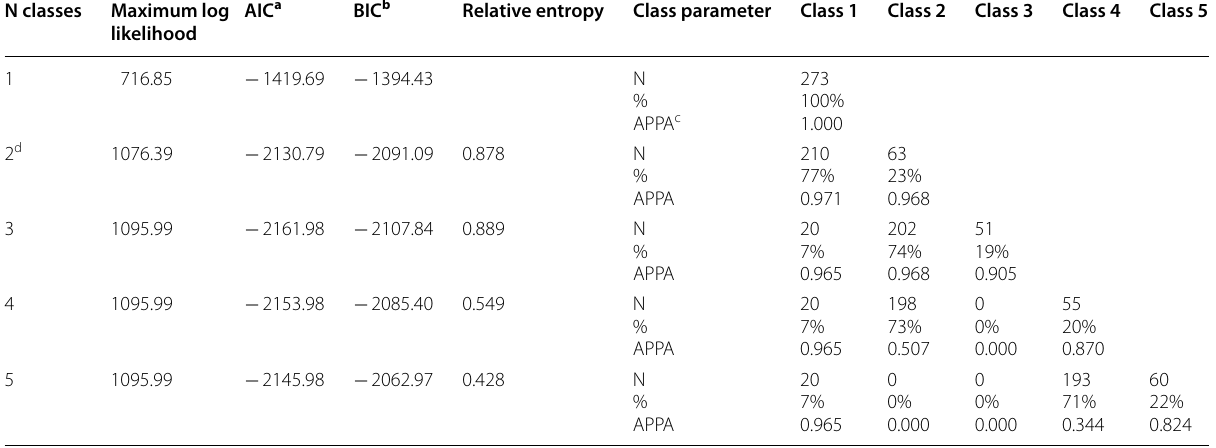
273) using a Quadratic Trajectory =